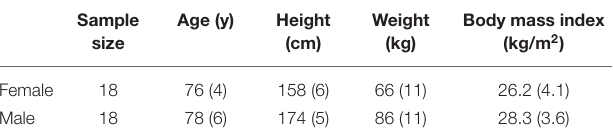
TABLE 1 | Participants’ characteristics. Sample